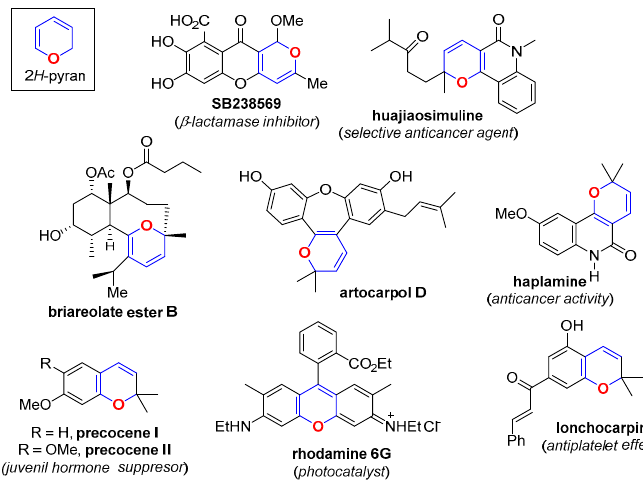
Figure 1. Examples of natural products containing the 2HP motif.